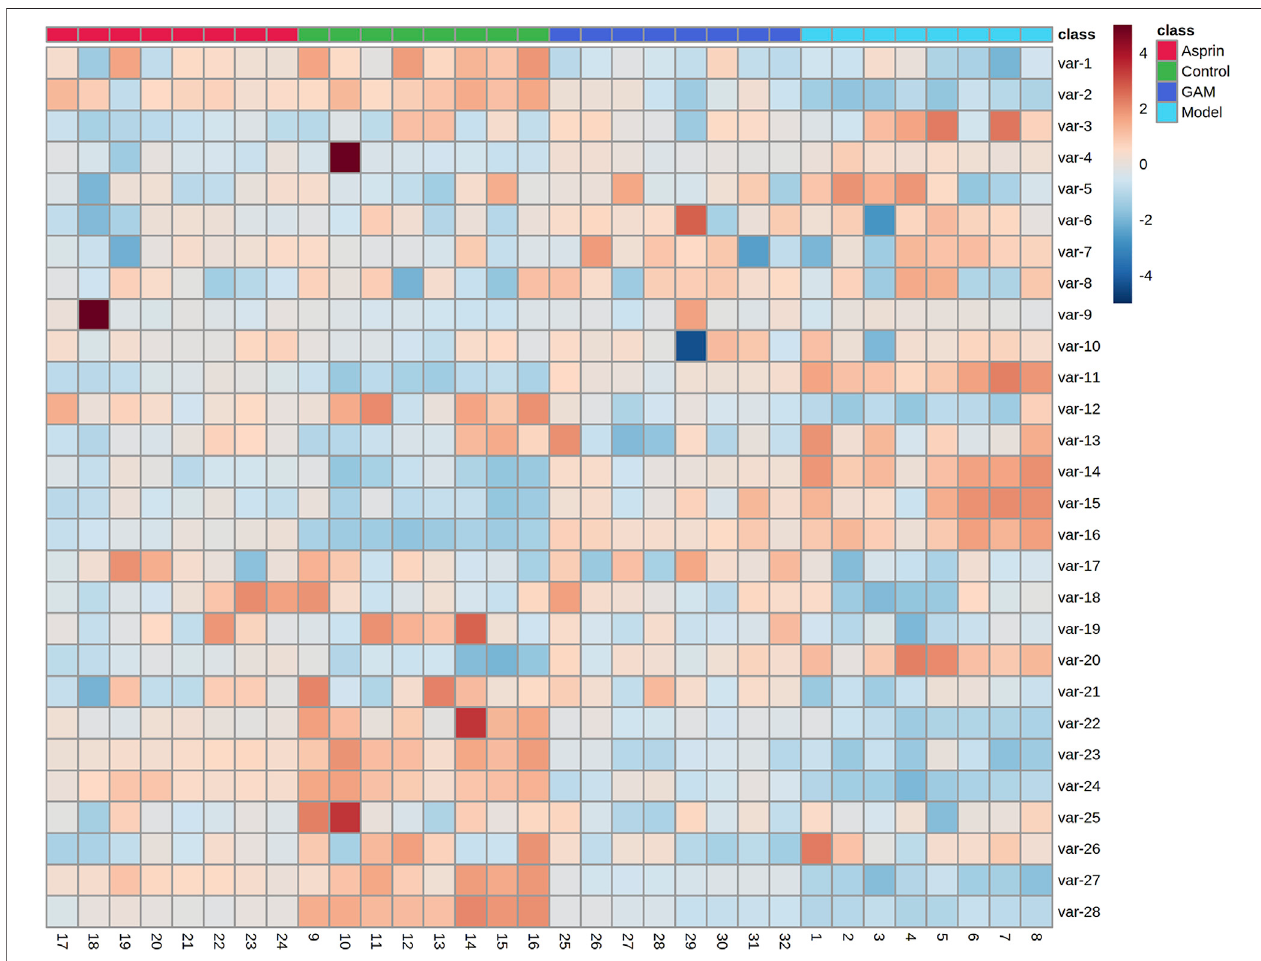
FIGURE 2 | Changes of metabolites of control, model, aspirin, and middle-dose gallic acid group.